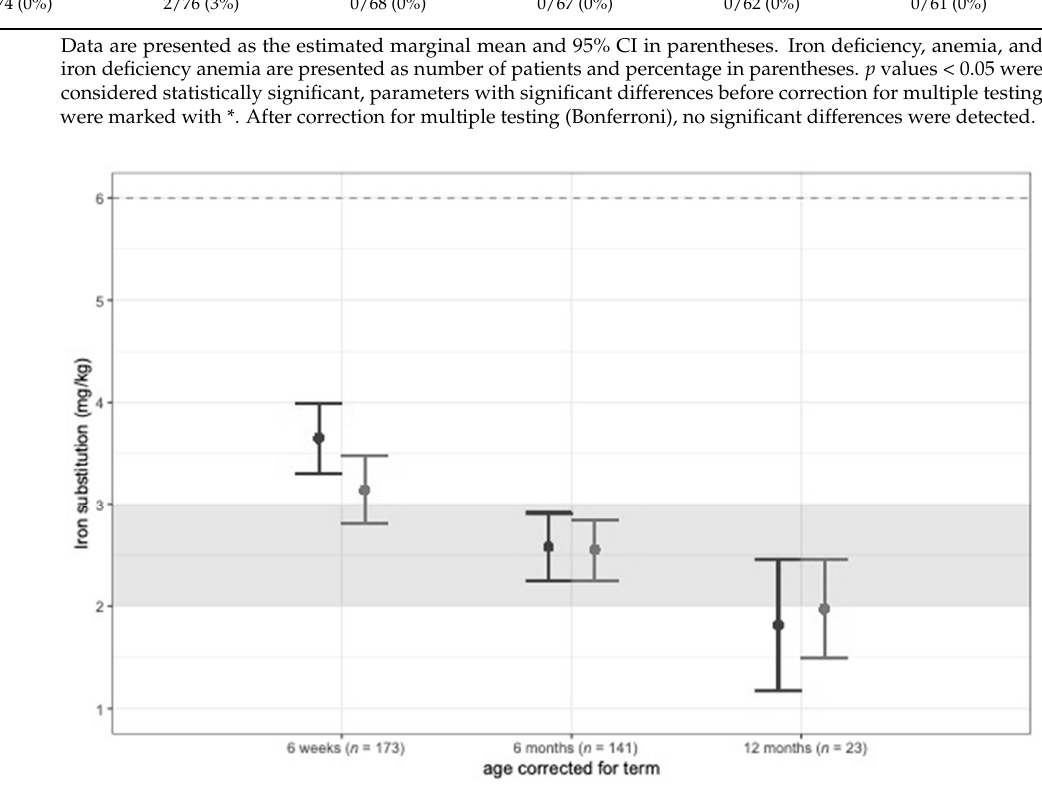
Figure 1. Ferritin levels (mcg/L) at 6 weeks, 6 months, and 12 months corrected age.